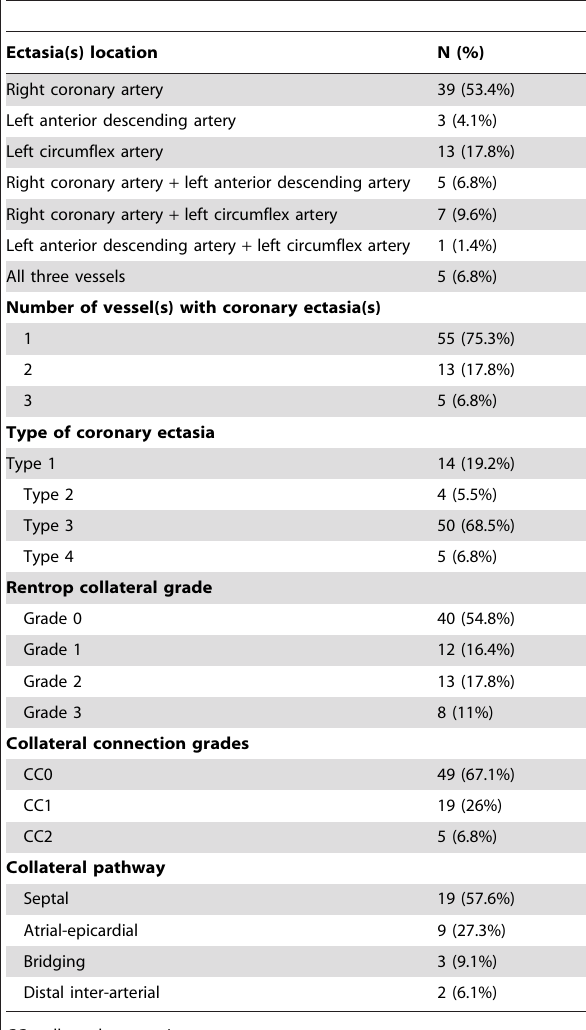
Table 2. Baseline Characteristics between Patients without and with Coronary Ectasia.